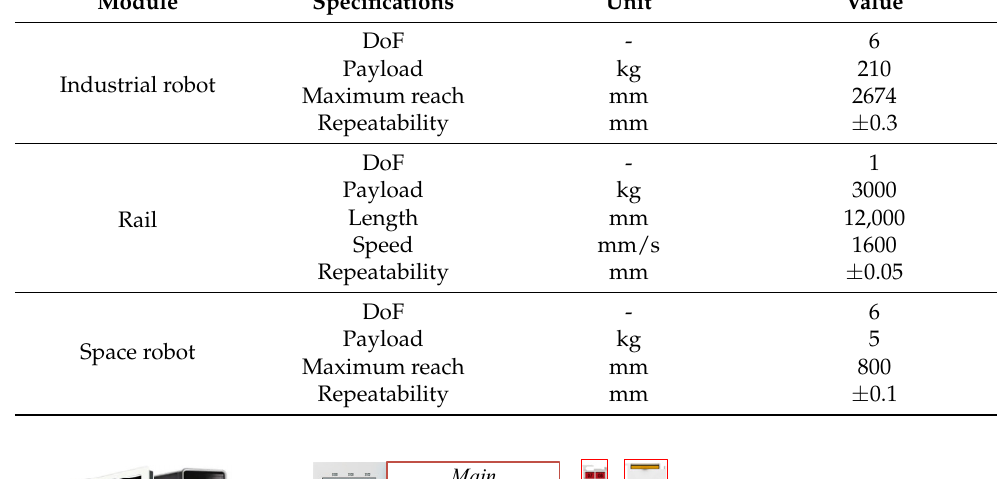
Figure 1. The HIL simulator.